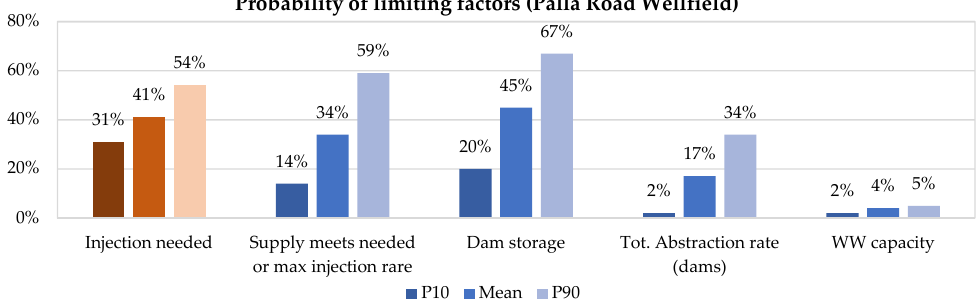
Figure 8. Factors limiting the injection at Palla Road Wellfield, Scenario C.